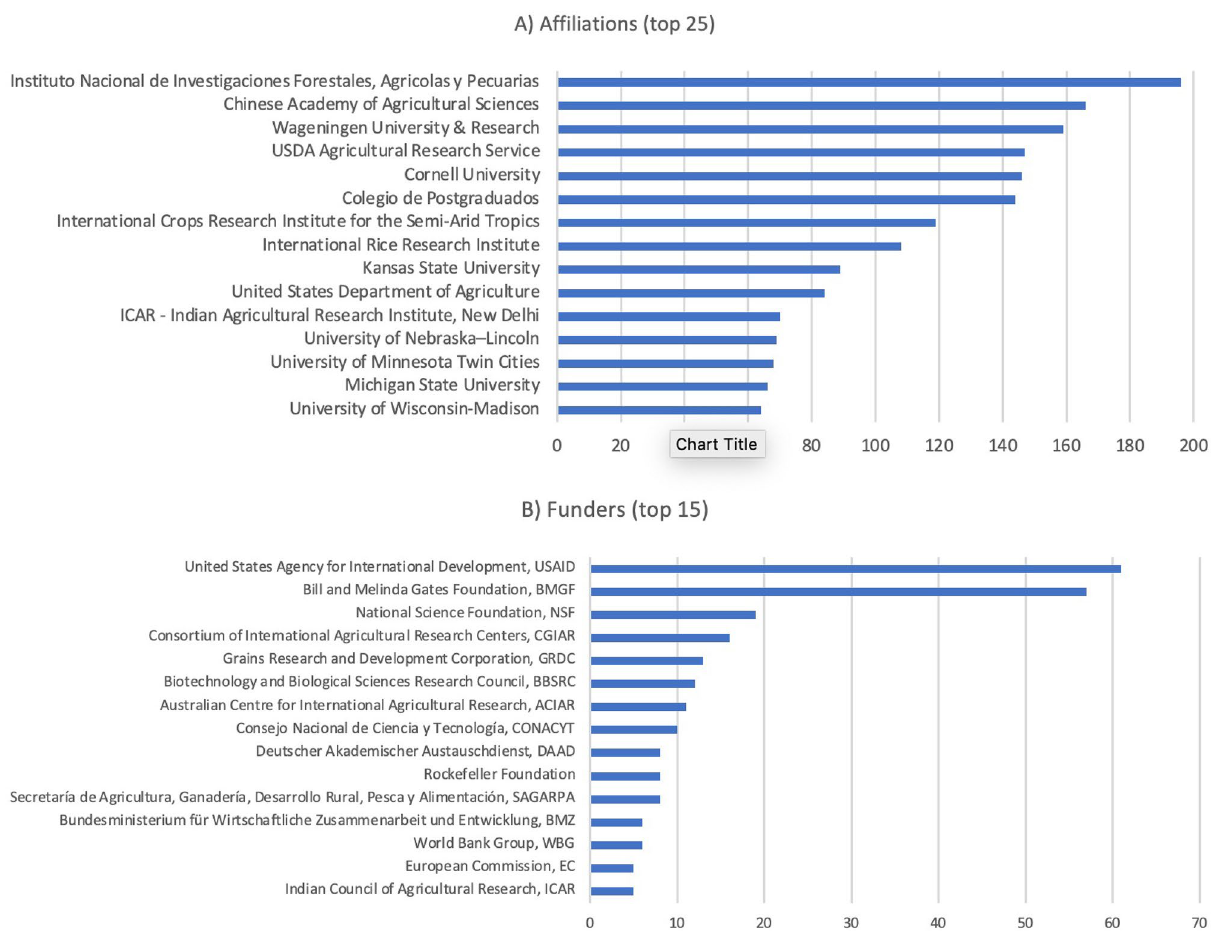
Figure 10. Most frequent institutional affiliations ( A ) and funders ( B ) identified in CIMMYT-affiliated climate- focused publications indexed by